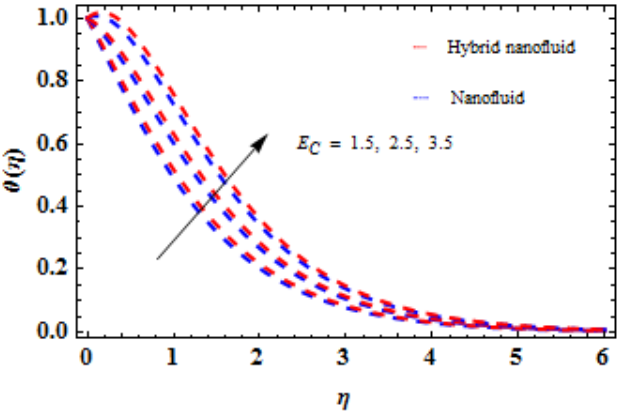
Figure 22. Influence of E C via θ ( η ) .